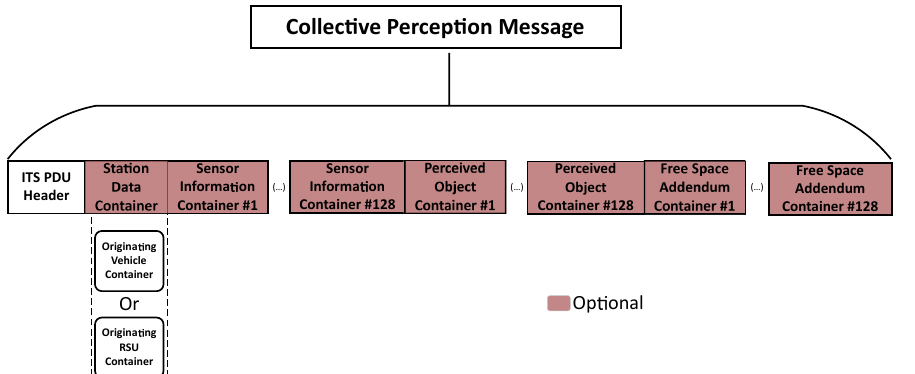
Figure 1. Collective Perception Message